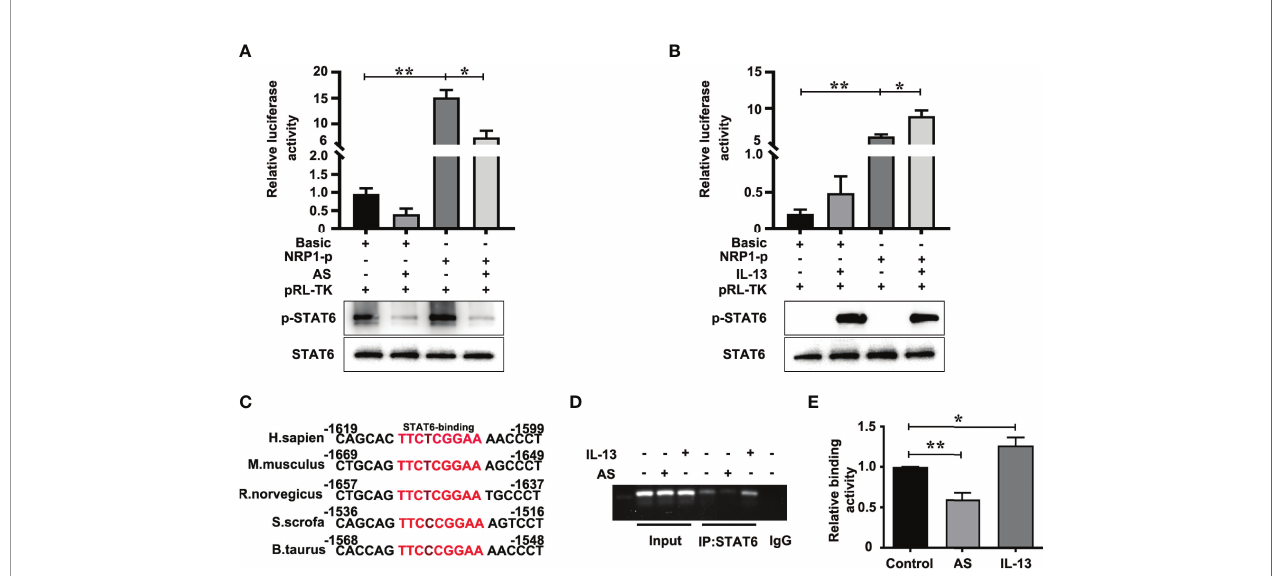
FIGURE 5 | STAT6 directly targets the NRP1 promoter in HUVECs. (A) Luciferase assay in HUVECs after transfection with pGL3-Basic (Basic) or pGL3- NRP1 prompter ( NRP1 -p) and then treated with or without AS (1 m M AS) for 24 (h) The level of phosphorylation of STAT6 and total STAT6 were also detected by western blotting, n=3, * P <0.05, NRP1 -p vs. NRP1 -p treated with AS, ** P <0.01 NRP1 -p vs. basic. (B) Luciferase assay in HUVECs after transfection with pGL3-Basic (Basic) or pGL3- NRP1 prompter ( NRP1 -p) and then treated with or without IL-13 (50 ng/mL) for 24 (h) The level of phosphorylation of STAT6 and total STAT6 were also detected by western blotting, n=3, * P <0.05, NRP1 -p vs. NRP1 -p treated with IL-13, ** P <0.01 NRP1 -p vs. basic. (C) The conserved sequence of STAT6 binding sites in the NRP1 promoter sequence were compared between different species. (D, E) ChIP assay was performed using anti-STAT6 antibody in HUVECs after treatment with AS (1 m M) or IL-13 (50 ng/mL) for 24 h, and then ampli fi ed by PCR, n=3, * P <0.05 vs. control, ** P <0.01 vs.